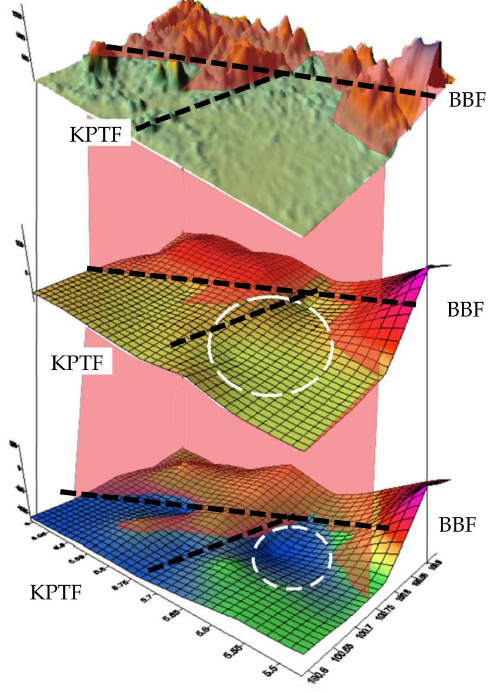
Figure 13. The red region indicates the extension of the granite body passing through the deep and shallow sources. The white dash line shows the downward basin depression.